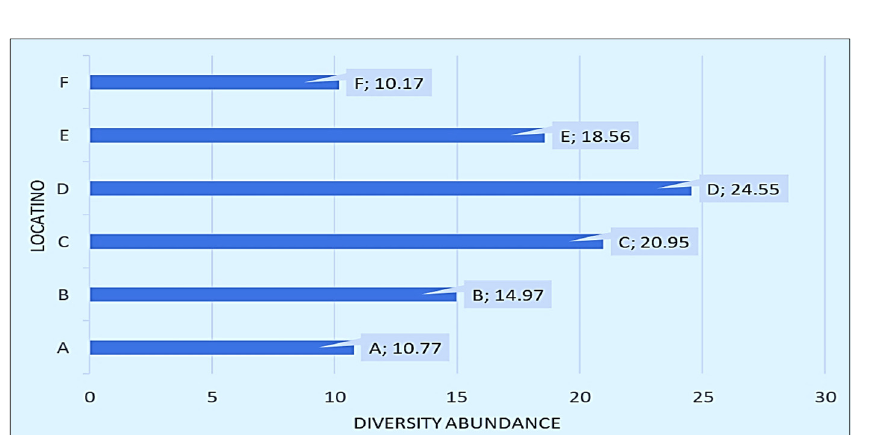
Table 2. Comparison of species’ percentages for each family in the flora of Aljumum and species diversity in Saudi Arabia.